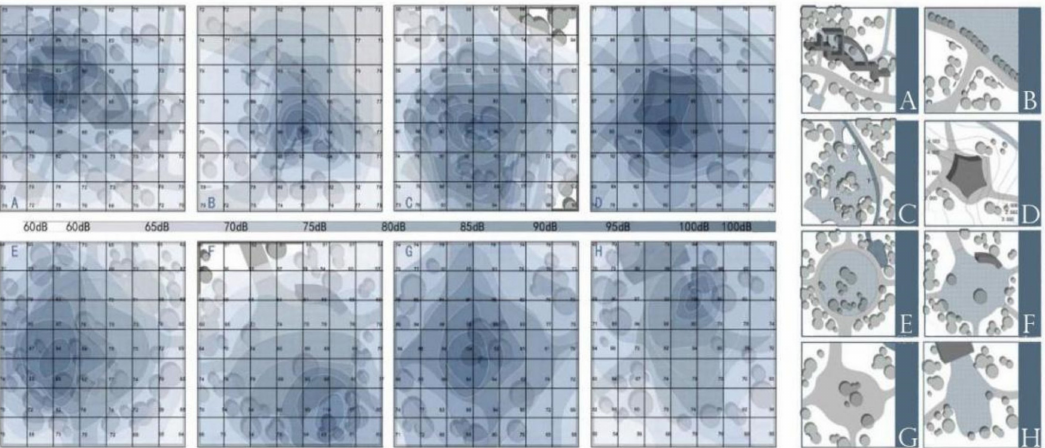
Figure 2. Eight characteristic spatial features and their acoustic environment. ( A ) Dynamic and external space, gallery and landscape walls, and slightly dense plants. ( B ) Internal space, intersection, few seat and plant; ( C ) Big size, sink terrain, and dense plants. ( D ) Static space, hilly terrain, pavilion, few plant; ( E ) Big size, Static space, external space, feature-rich, and dense plants. ( F ) Big size, dynamic and external space, pavilion, seat, and slightly dense plants. ( G ) Small size, dynamic and external space, no pavement, close to fishing ground, and few plants. ( H ) Small size, dynamic and external space, one side with building, and few